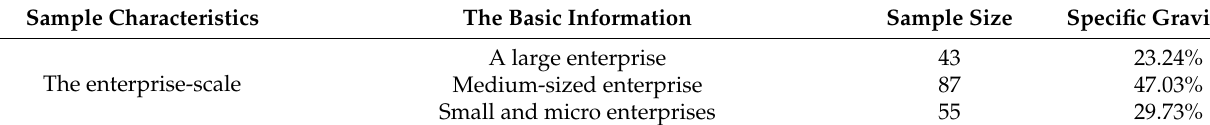
Table 1. Distribution of basic features of samples (N =